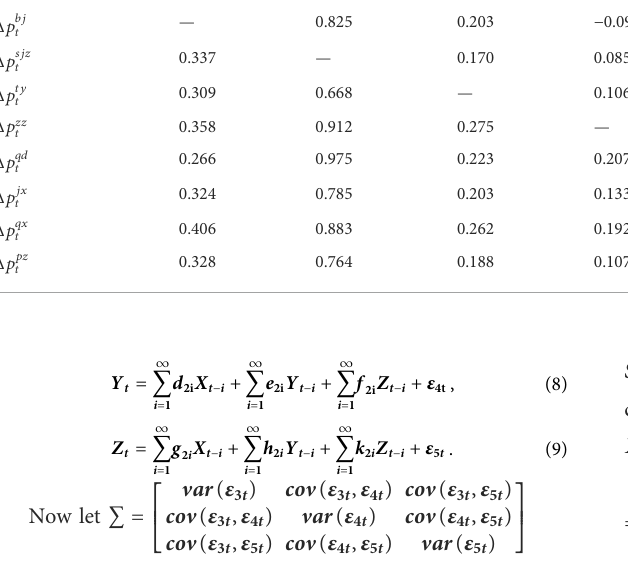
TABLE 5 Values of the partial Granger causality test statistics for garlic prices.